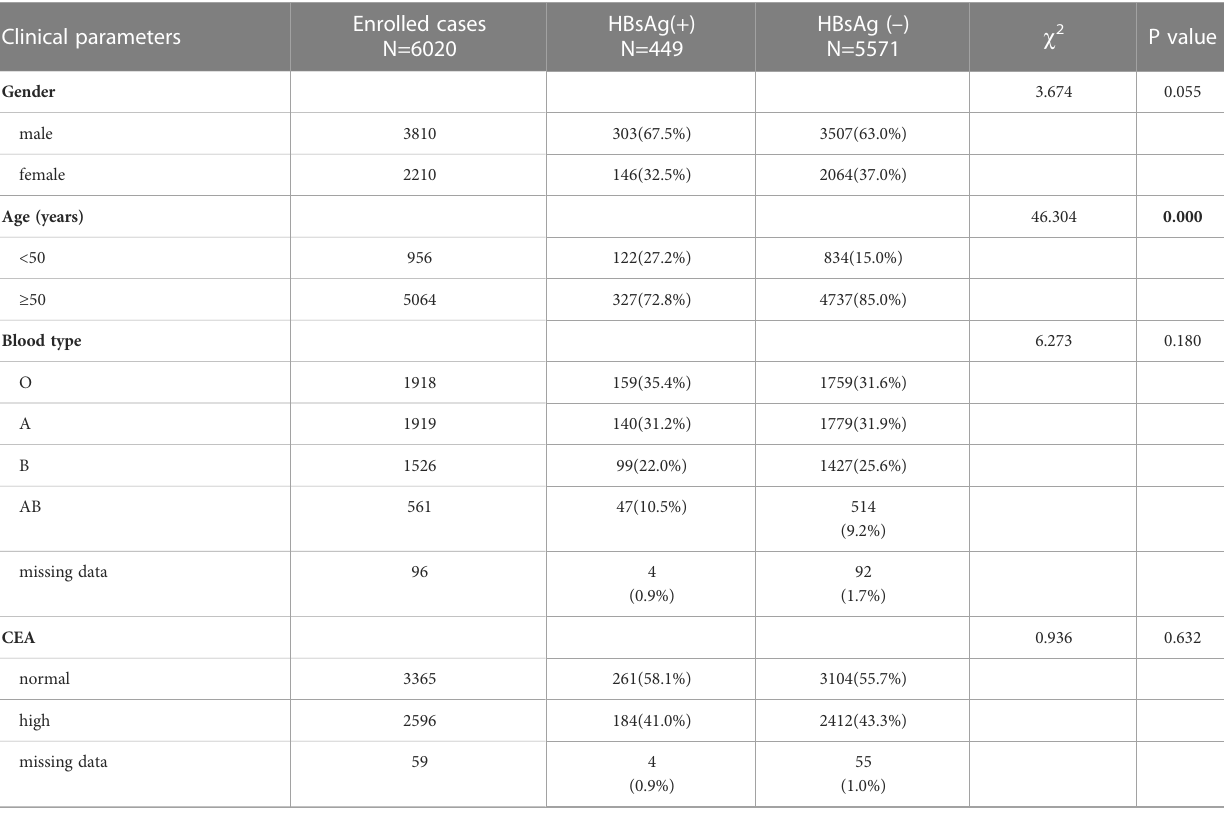
TABLE 1 Clinical parameters and